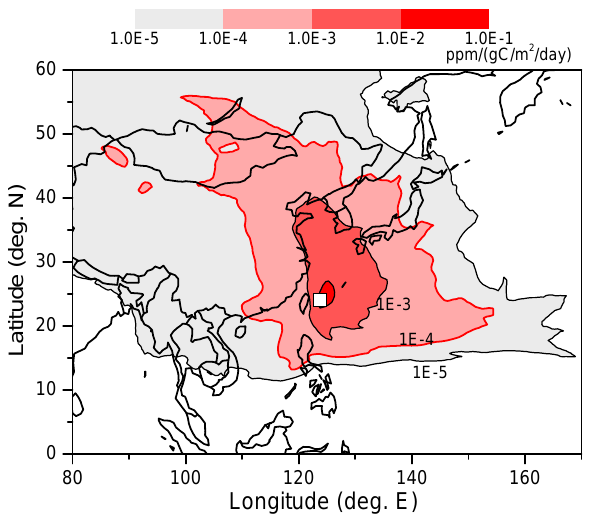
Fig. 5. Average footprint (ppm (gCm − 2 day − 1 ) − 1 ) for the mea- surements at HAT during the winter period (November to March). Meteorological data for 2006–2010 are used for the calculation. The location of HAT is indicated by the square. The area surrounded by the red thick contour lines of 1 × 10 − 4 ppm (gCm − 2 day − 1 ) − 1 is defined as an effective footprint area (EFA).